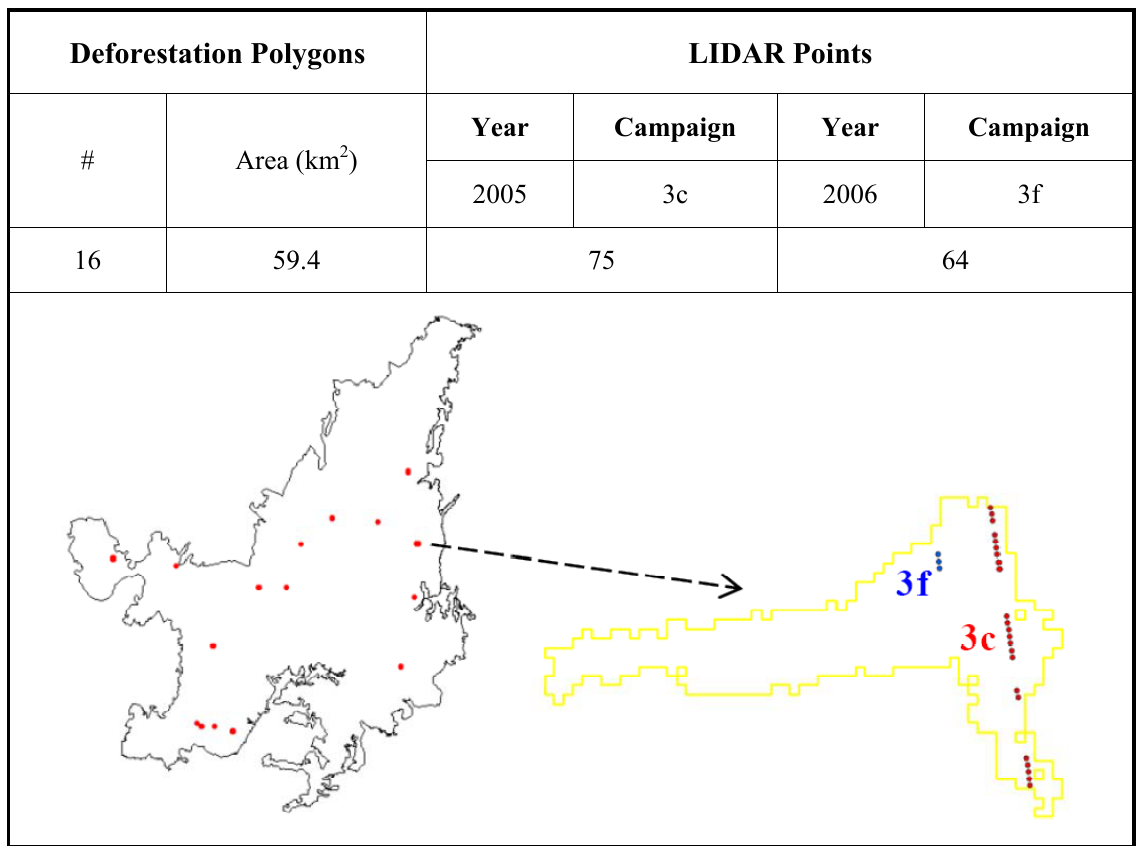
Table 5. Deforestation polygons with “coincident” LIDAR acquisitions from the 3c and 3f GLAS campaigns (the inset gives a detailed look at one of these deforestation polygons).